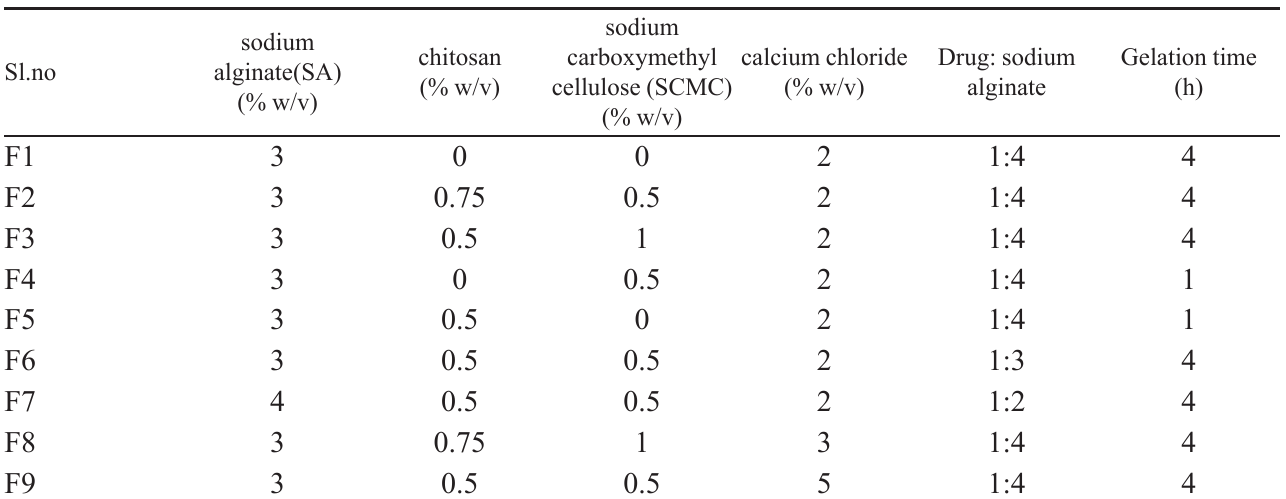
TABLE I - Formulation design